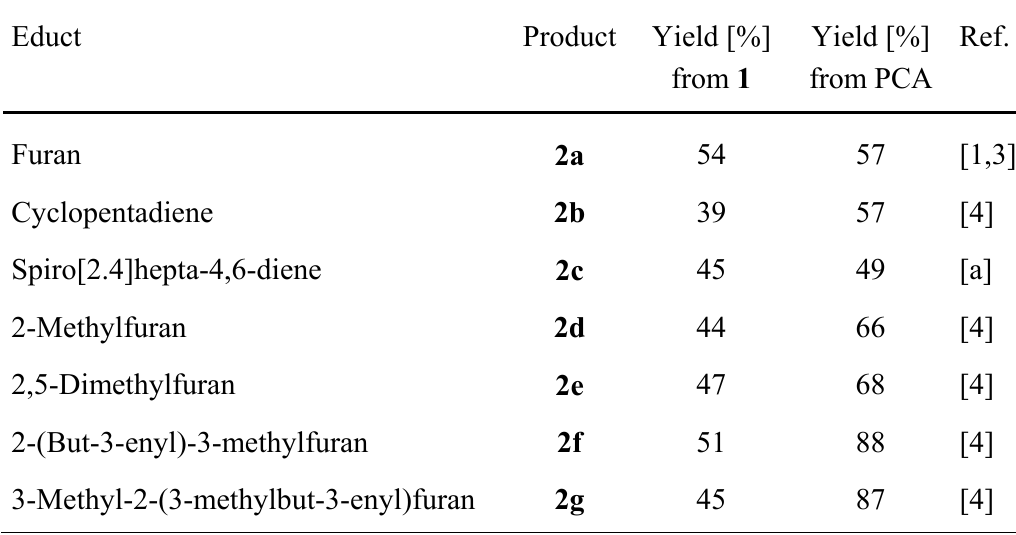
Table 1. Tetrachloro-substituted [3.2.1]bicycles ( 2 ) from 1 , and PCA,